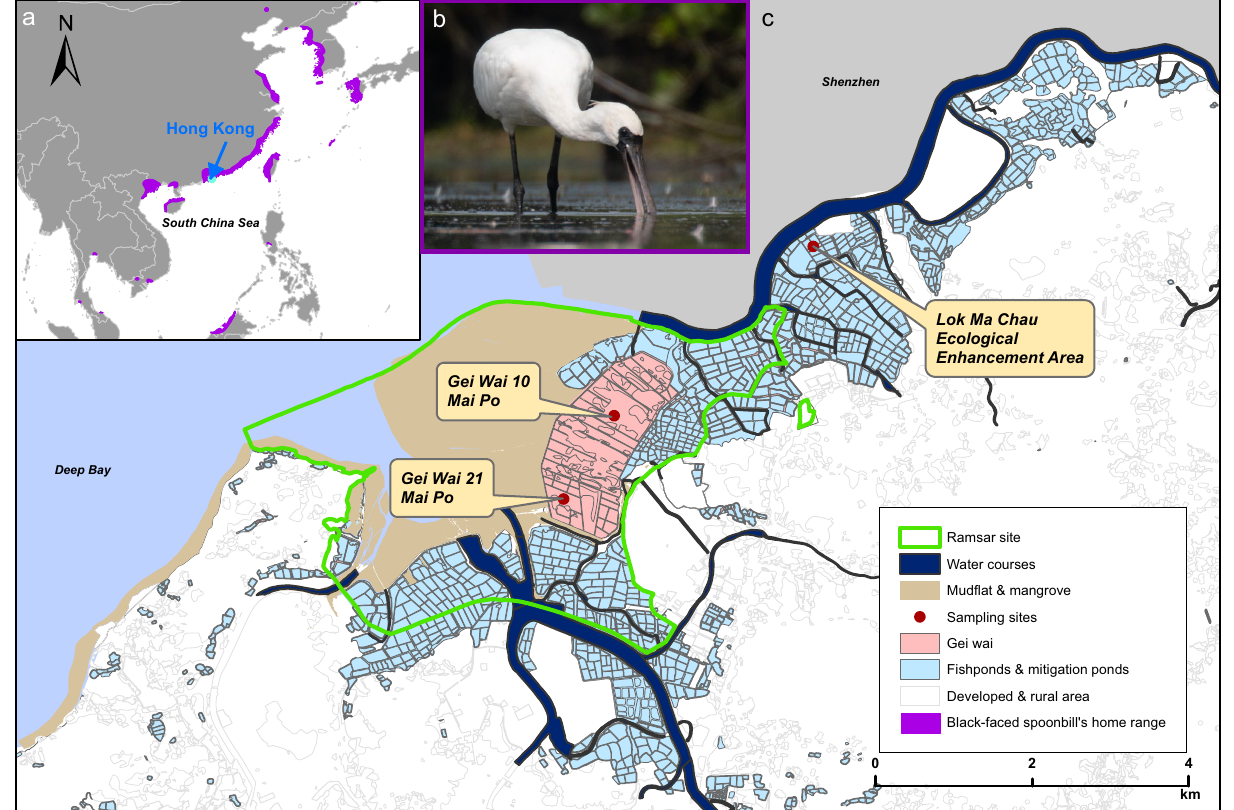
Figure 1. Sampling sites of the wintering black-faced spoonbill ( Platalea minor ). (a) Map of East Asia with purple regions indicates the distribution range. (b) Platalea minor wades to feed near mangroves in the Mai Po Inner Deep Bay Ramsar Site. Photo credit: Hon Shing Fung. (c) Map of the northwestern part of Hong Kong where the wetland complex is located. The map was made using ArcGIS version 10.7 70